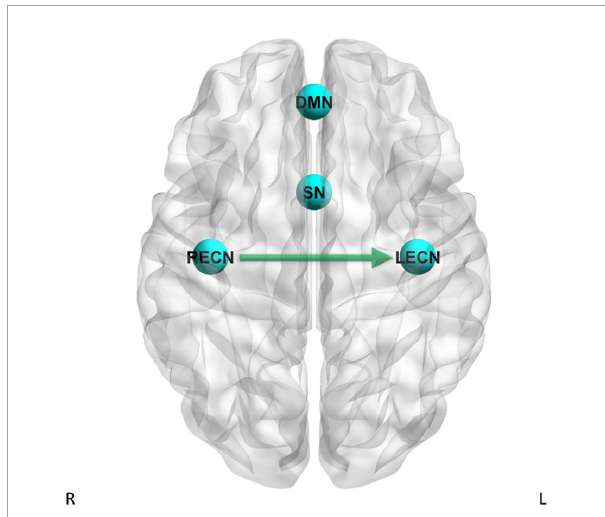
FIGURE4 Dynamic causal modeling PEB results – group differences with current tobacco use status as factor in the GLM. Green arrow = CD has stronger effective connectivity than